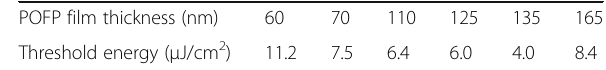
Table 1 The relationship between POFP film thickness and threshold